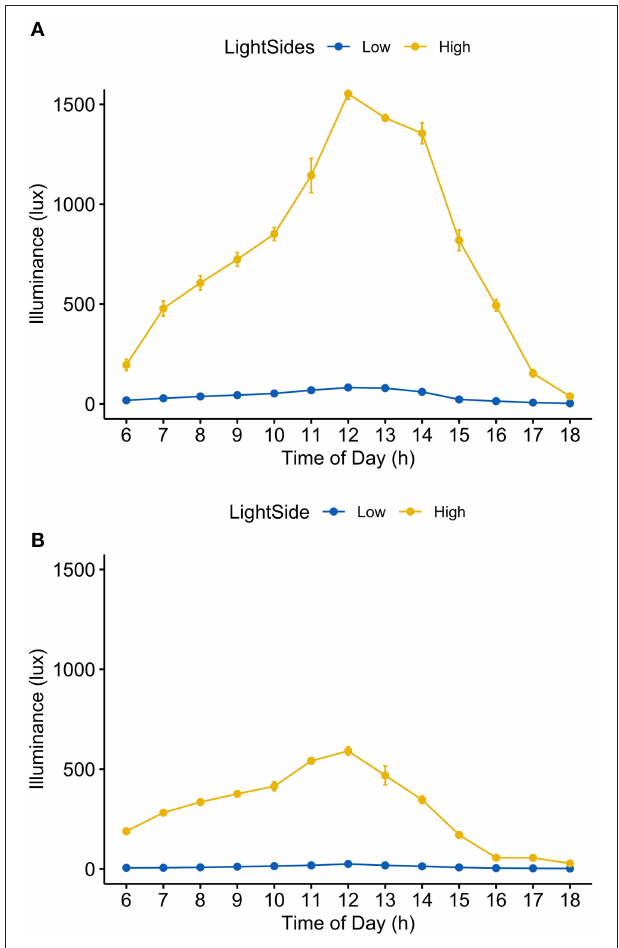
FIGURE 3 | Light intensity by light sides of the hospital unit in two sky conditions. (A) Sunny day; (B) overcast day.